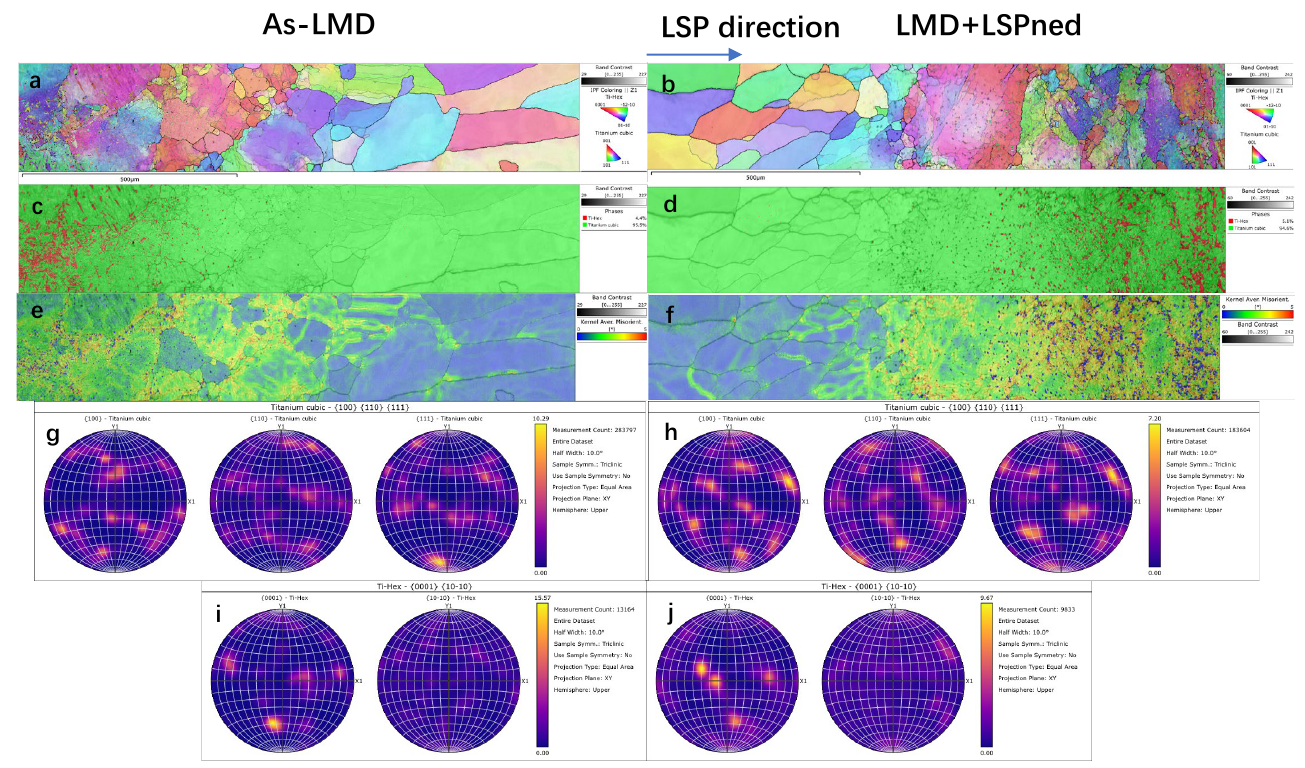
Figure 8. EBSD analysis of HAZ area of as-LMD and LMD+LSPned samples. ( a , b ) IPF Z mappings; ( c , d ) phase mappings; ( e , f ) KAM mappings; ( g , h ) pole figures for hcp and cubic phase. ( i , j ) pole figures for cubic phase.